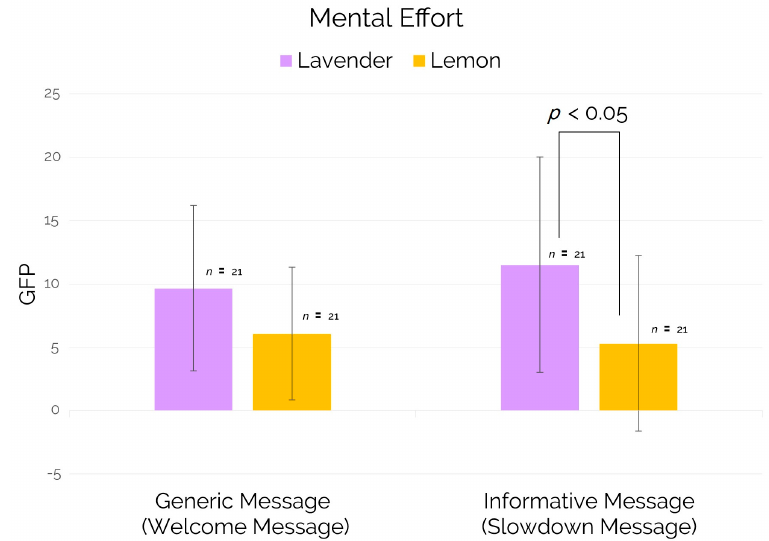
Figure 8. Mental Effort for the time segments associated respectively to the generic message (wel- come message) and the informative message (slowdown message).